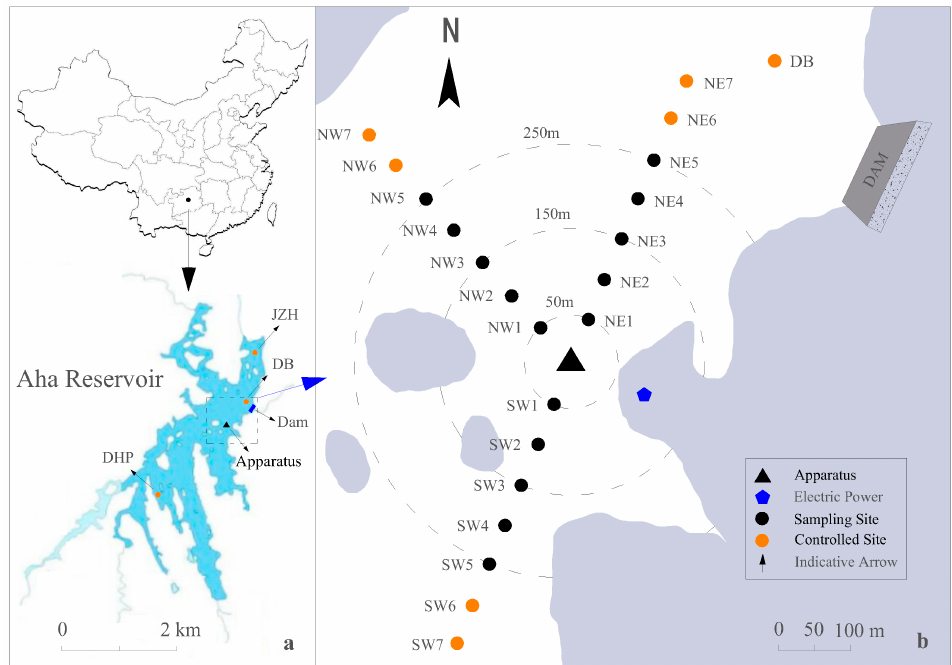
Figure 1. Study area ( a ) and sampling sites ( b ).